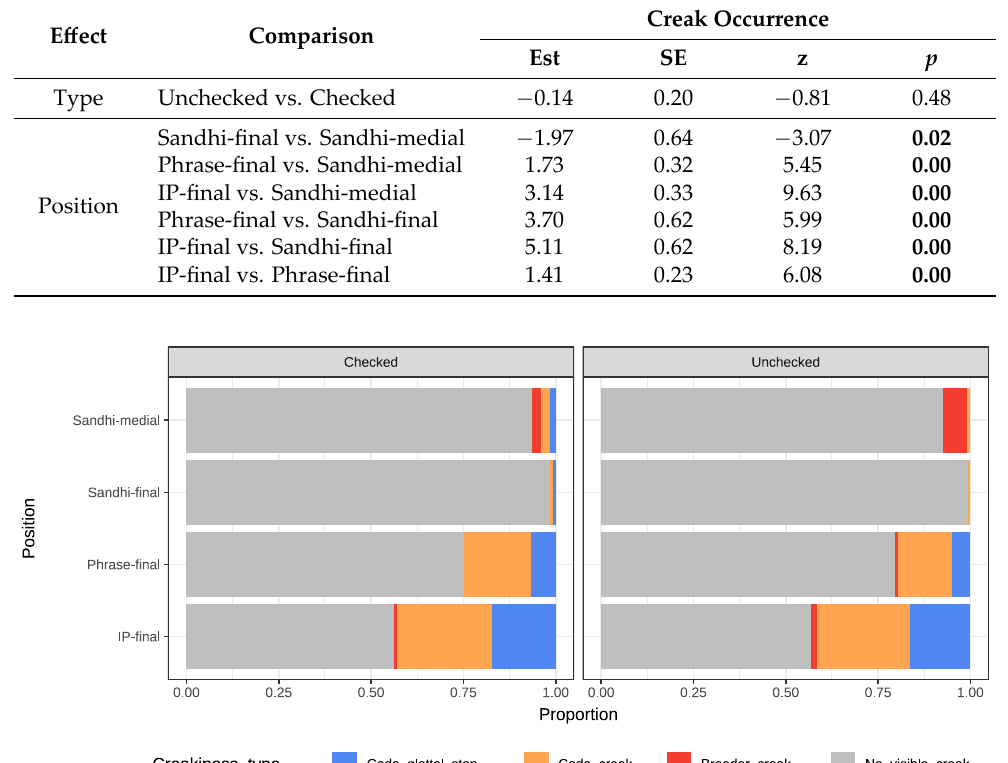
Table 8. Outputs of logistic mixed‑effect regression model for the occurrence of creak (three creak‑ types combined). Significant p ‑values ( p ⩽ 0.05 ) are marked in bold.